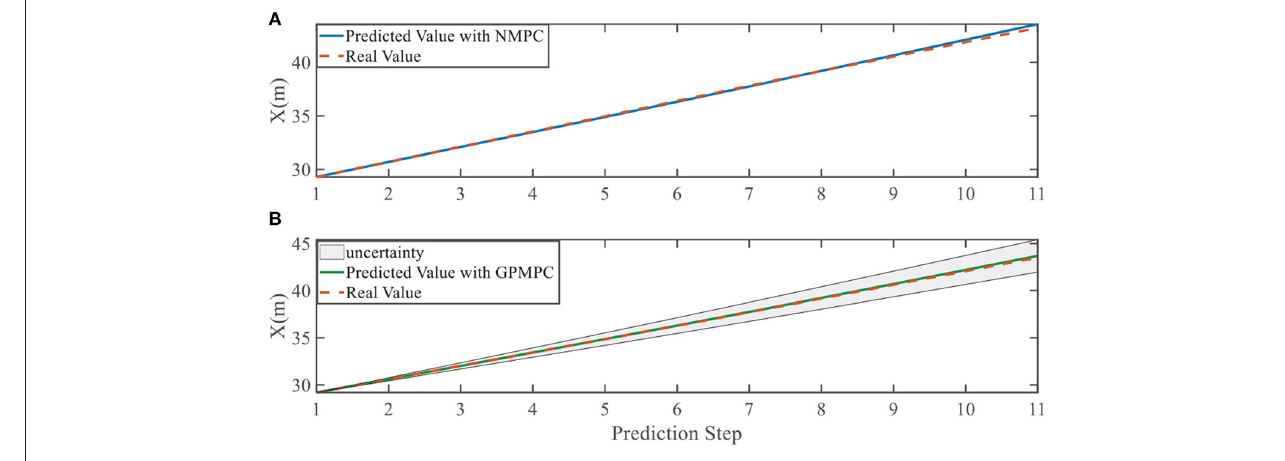
FIGURE 7 | Position X evolution in left overtaking. (A) NMPC; (B) GPMPC.